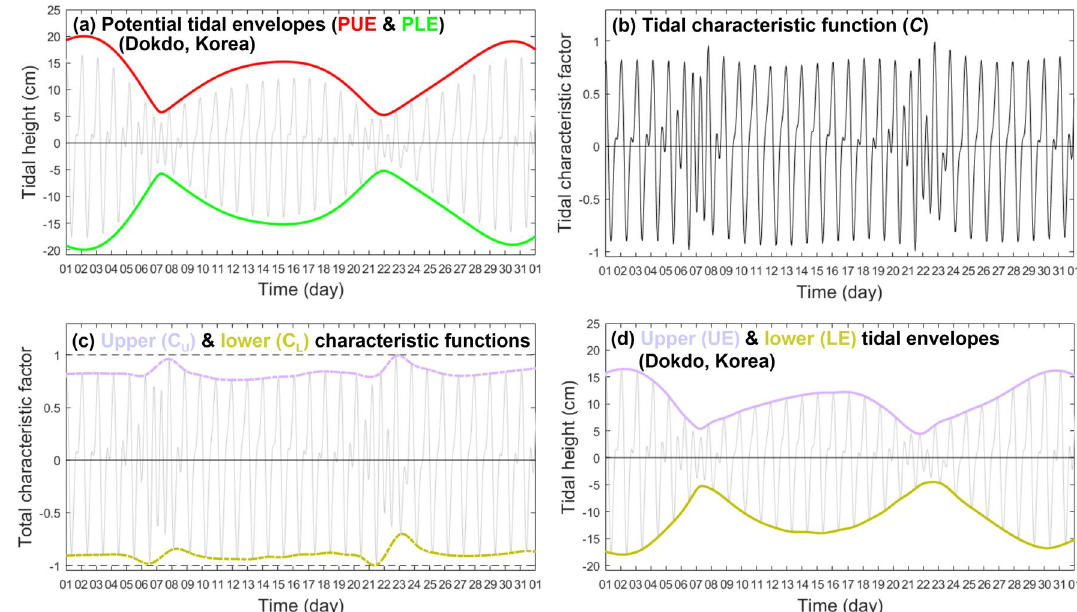
Figure 5. Example procedure for and results of calculating an actual monthly tidal envelope, using sea levels from Dokdo, Korea (August 1 to 31, 2009) and Eqs. (5a), (5b), (6), (7), (8a), and (8b): ( a ) potential maximum upper (PEU, red) and lower (PLE, green) tidal envelopes, compared to actual tidal heights (grey); ( b ) the tidal characteristic function, C , that is the ratio between actual tidal heights and PUE; ( c ) tidal characteristic function envelopes, C U and C L , derived from interpolation of the maximum daily peaks and troughs of C ; and ( d ) actual upper (UE, purple) and lower (LE, yellow) tidal envelopes, calculated by multiplying PUE by C U and C L